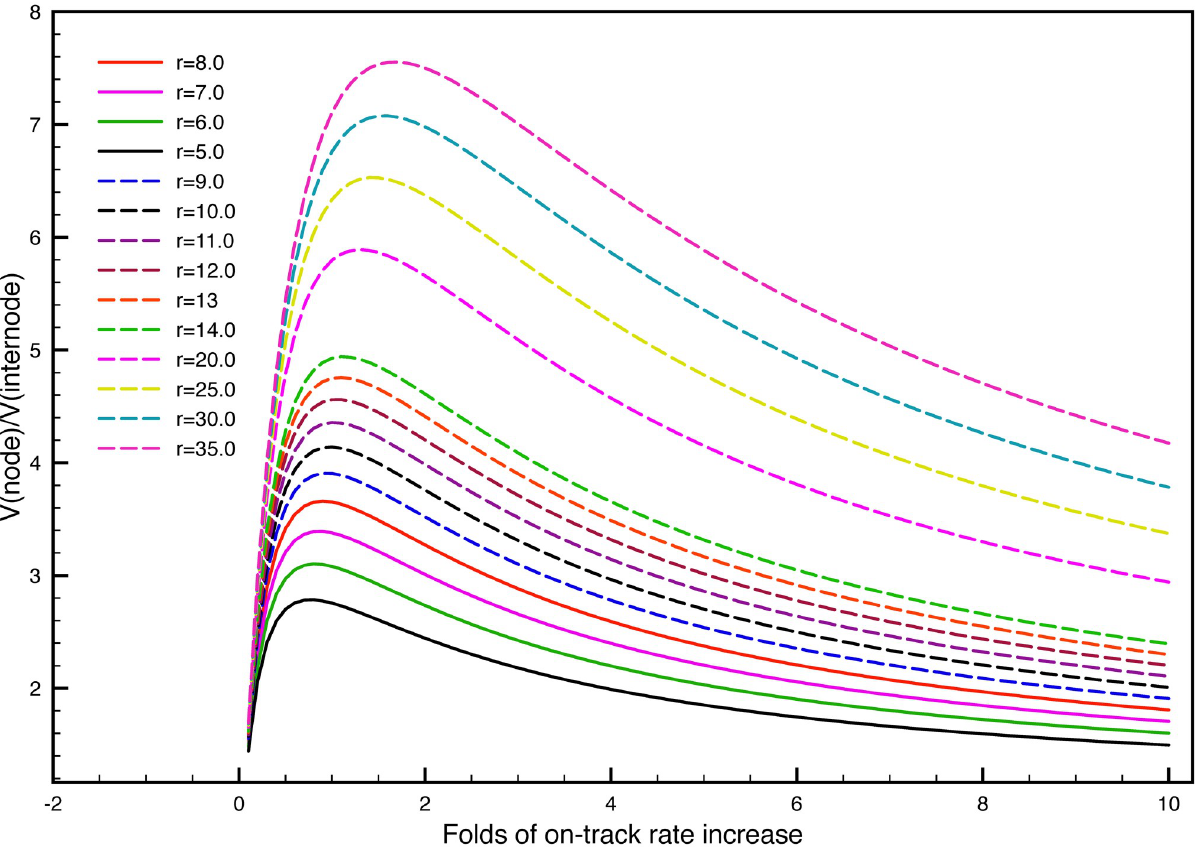
Fig 6. The velocity acceleration in the node depends on the parameter of r and increase folds of g 2 rate g 2 for both the node and internode, increasing from g 2 on